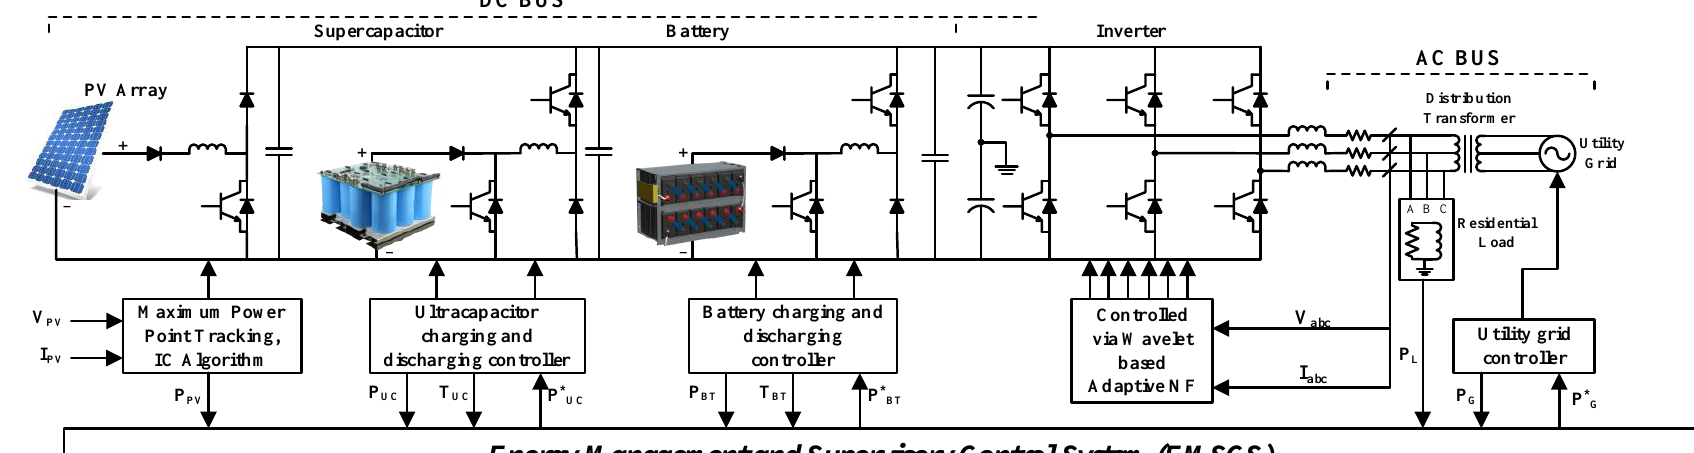
Figure 1. Structure of the proposed microgrid.